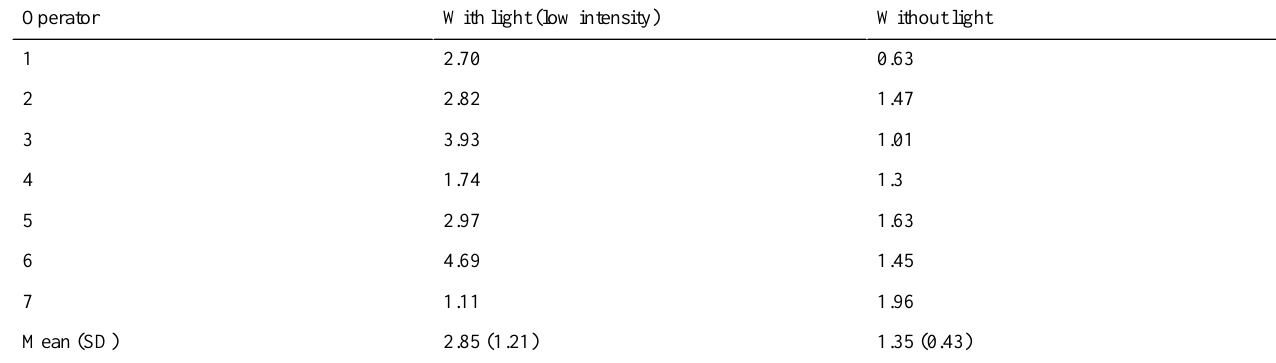
Table 4. Static error with or without light